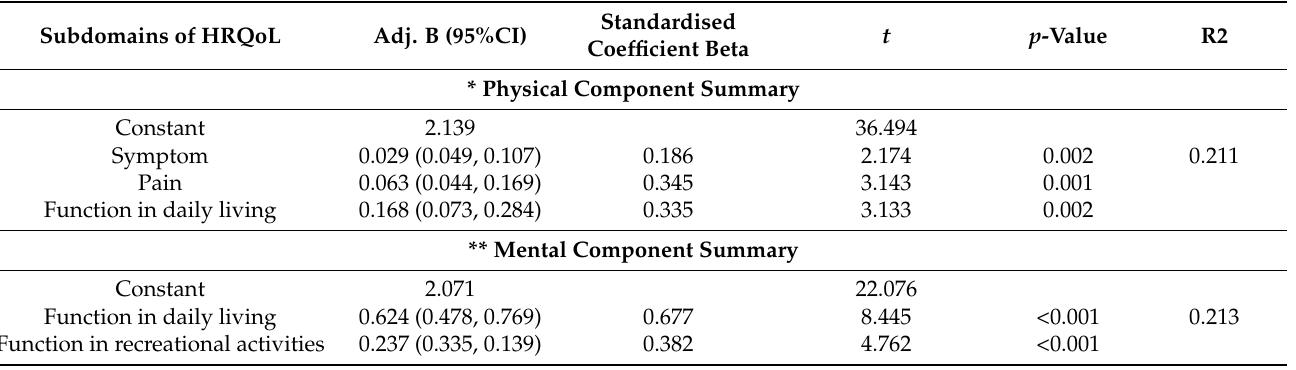
Coefficient table MLR (Stepwise method). * Model: R-square = 0.211, Durbin–Watson = 1.526, no problems in multicollinearity, no interaction, model fit. ** Model: R-square = 0.213, Durbin–Watson = 1.333, no problems in multicollinearity, no interaction, model